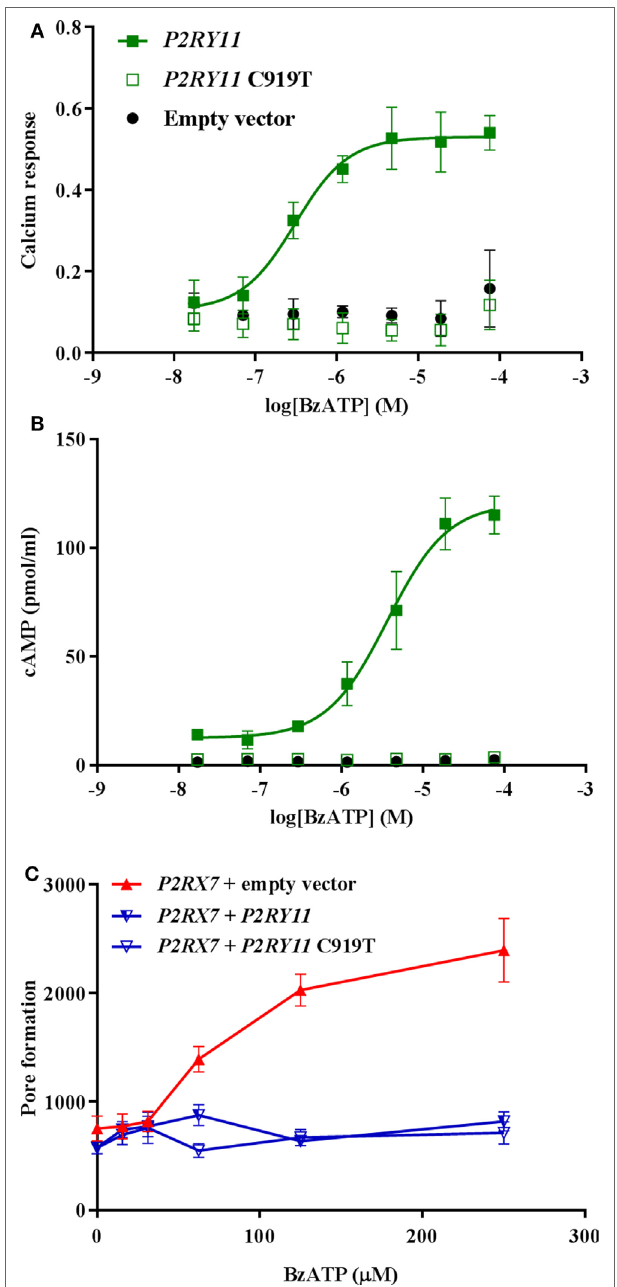
FigUre 7 | The effect of P2Y 11 on P2X7-mediated pore formation is not dependent on P2Y 11 signaling. Stimulation with various concentrations of BzATP of transiently transfected GripTite cells expressing empty vector (black), P2RY11 (closed green square), or P2RY11 C919T (open green square) vector in (a) calcium assay measured by Fluo-4, data are shown as mean ± SEM, n = 3,6 from 1 to 2 independent runs. (b) cAMP response, data are shown as mean ± SEM, n = 3,6 from 1 to 2 independent runs. (c) YO-PRO-1 dye uptake as a measure of P2X7 receptor pore formation in cells transfected with P2RX7 + empty vector (red), P2RX7 + P2RY11 (half-open blue triangle), and P2RX7 + P2RY11 C919T (open blue triangle). Data are shown as mean ± SEM, n = 9 from three independent runs. Part of data was previously published by Ref. (25).